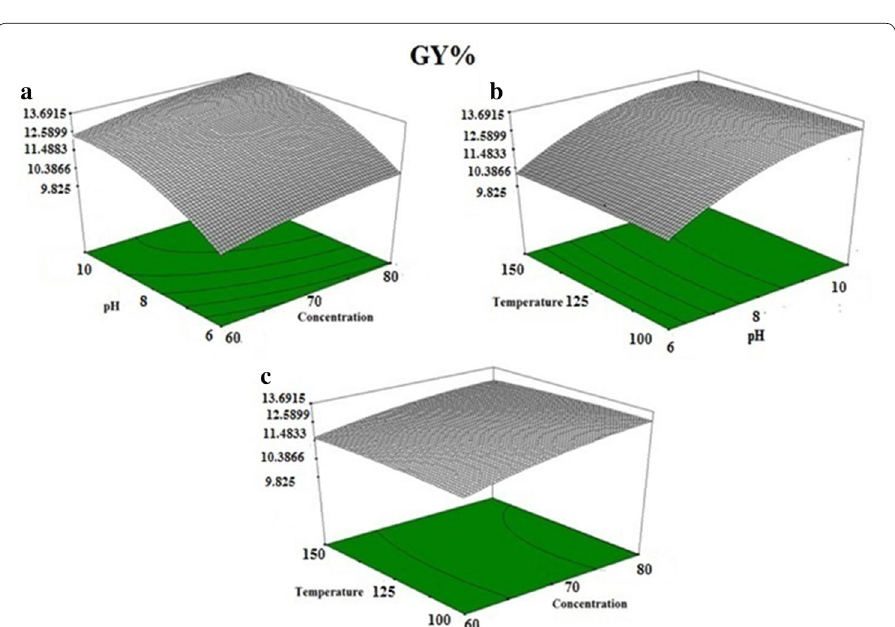
Fig. 4 Effect of a pH and concentration, b pH and temperature, c temperature and concentration on